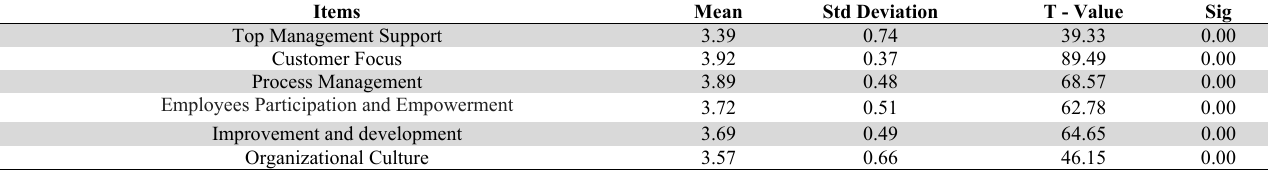
One Sample T-test results of applying Total Quality dimensions and organizational culture.